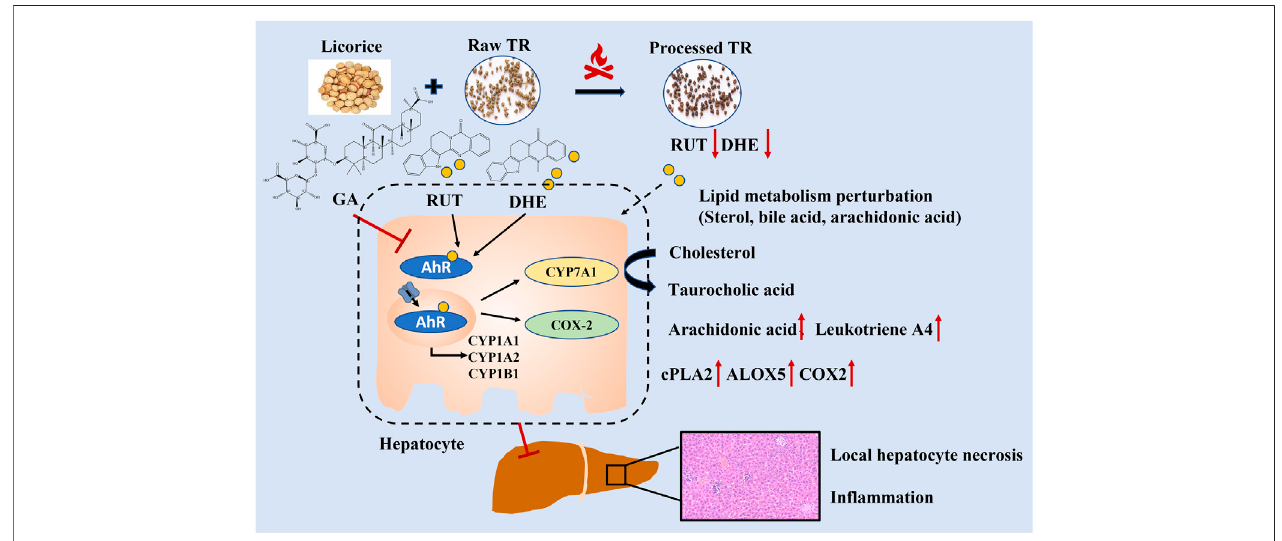
FIGURE 6 | Toxicity and toxicity attenuation mechanisms of raw and processed TR in